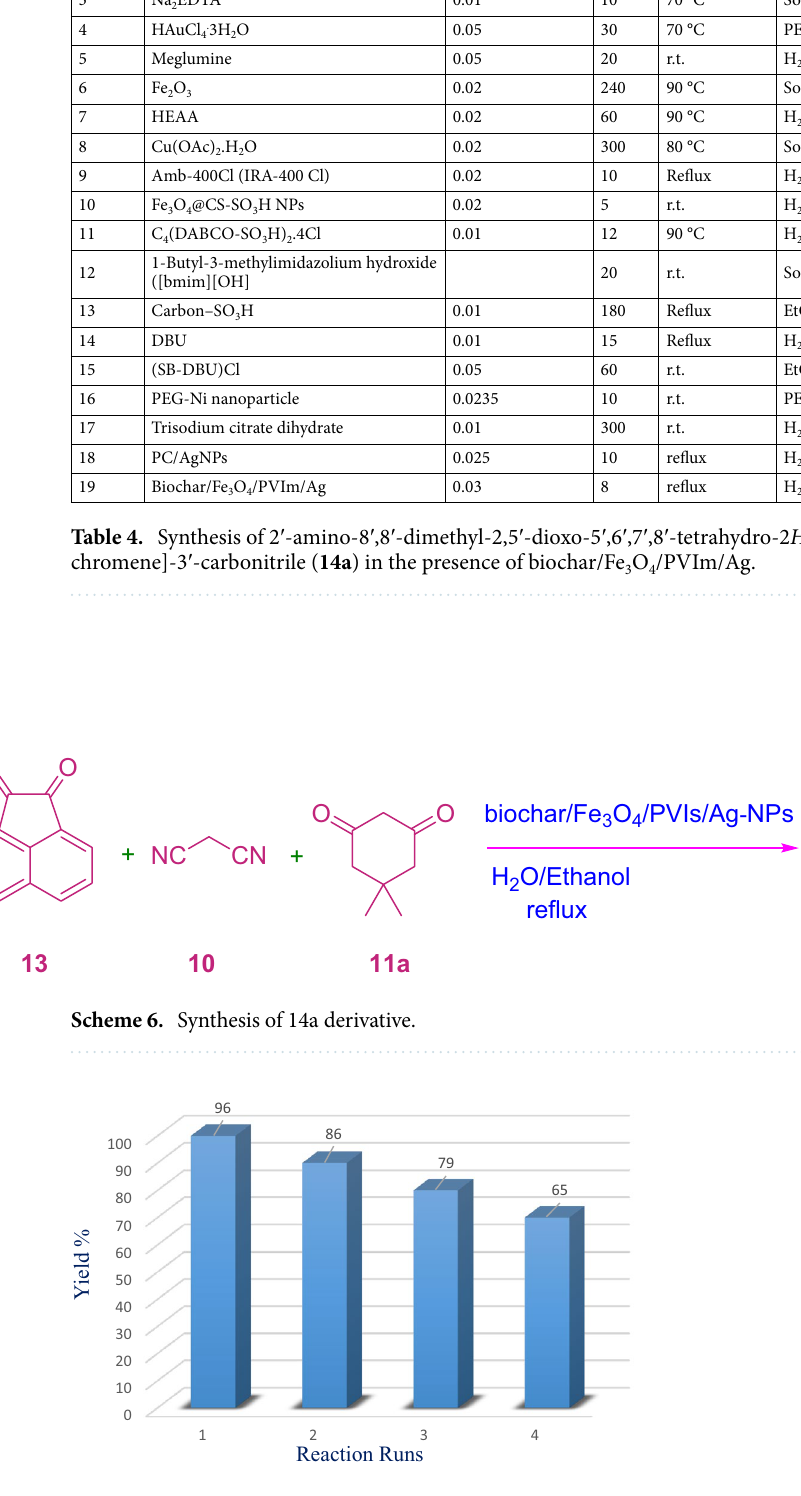
Figure 10. Normal reusability of our new catalyst within the alertness of admixture